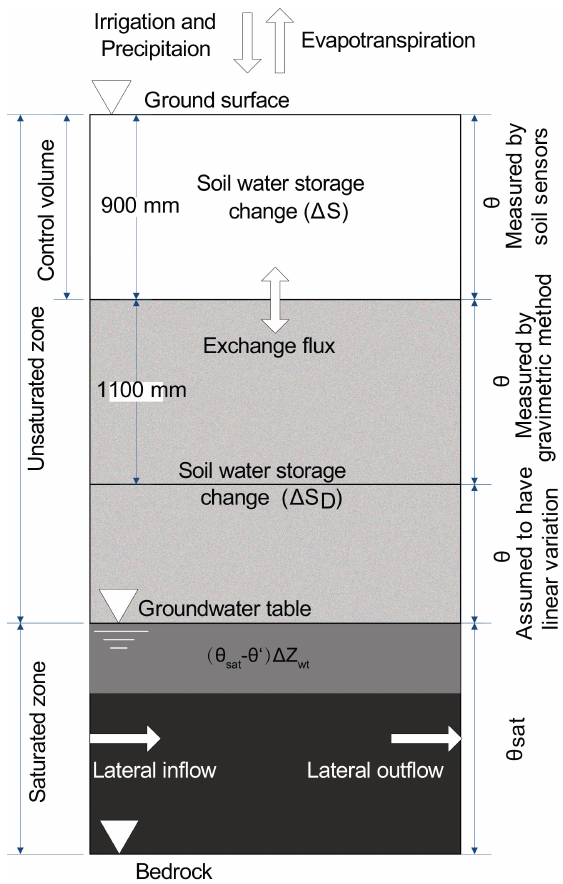
Figure 3. Analysis zone for water balance and groundwater dynam-